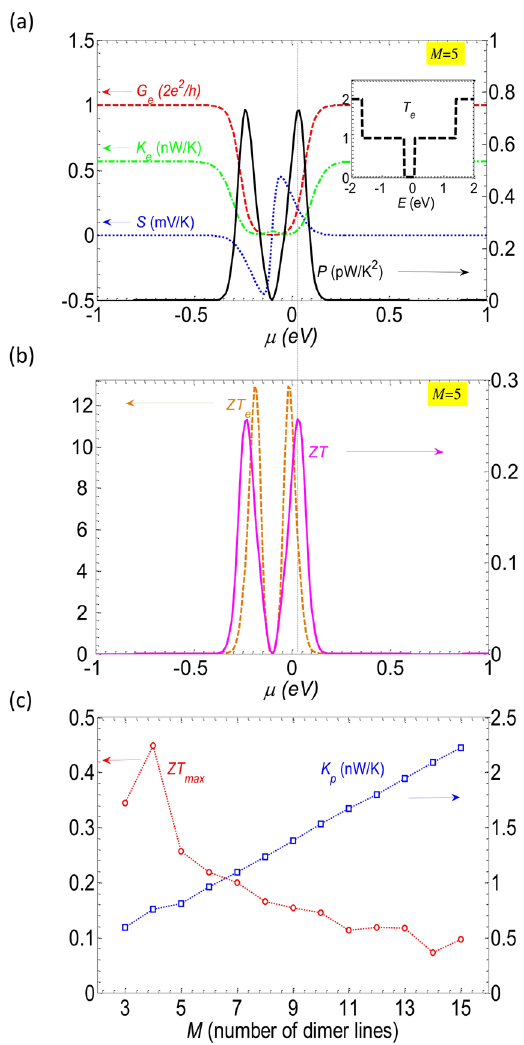
Figure 2. Electronic and thermoelectric properties of a pristine structure of width M = 5 at room temperature. ( a ) The electrical conductance, the Seebeck coefficient, the electron thermal conductance and the power factor plotted as functions of chemical potential. The inset reports the transmission spectrum. ( b ) The electronic and total figure of merit ZT e and ZT . ( c ) Maximum value of figure of merit ZT max and K p in different ribbons displayed as a function of M . In ( a ) and ( b ) the vertical dotted line indicates the position of ZT max